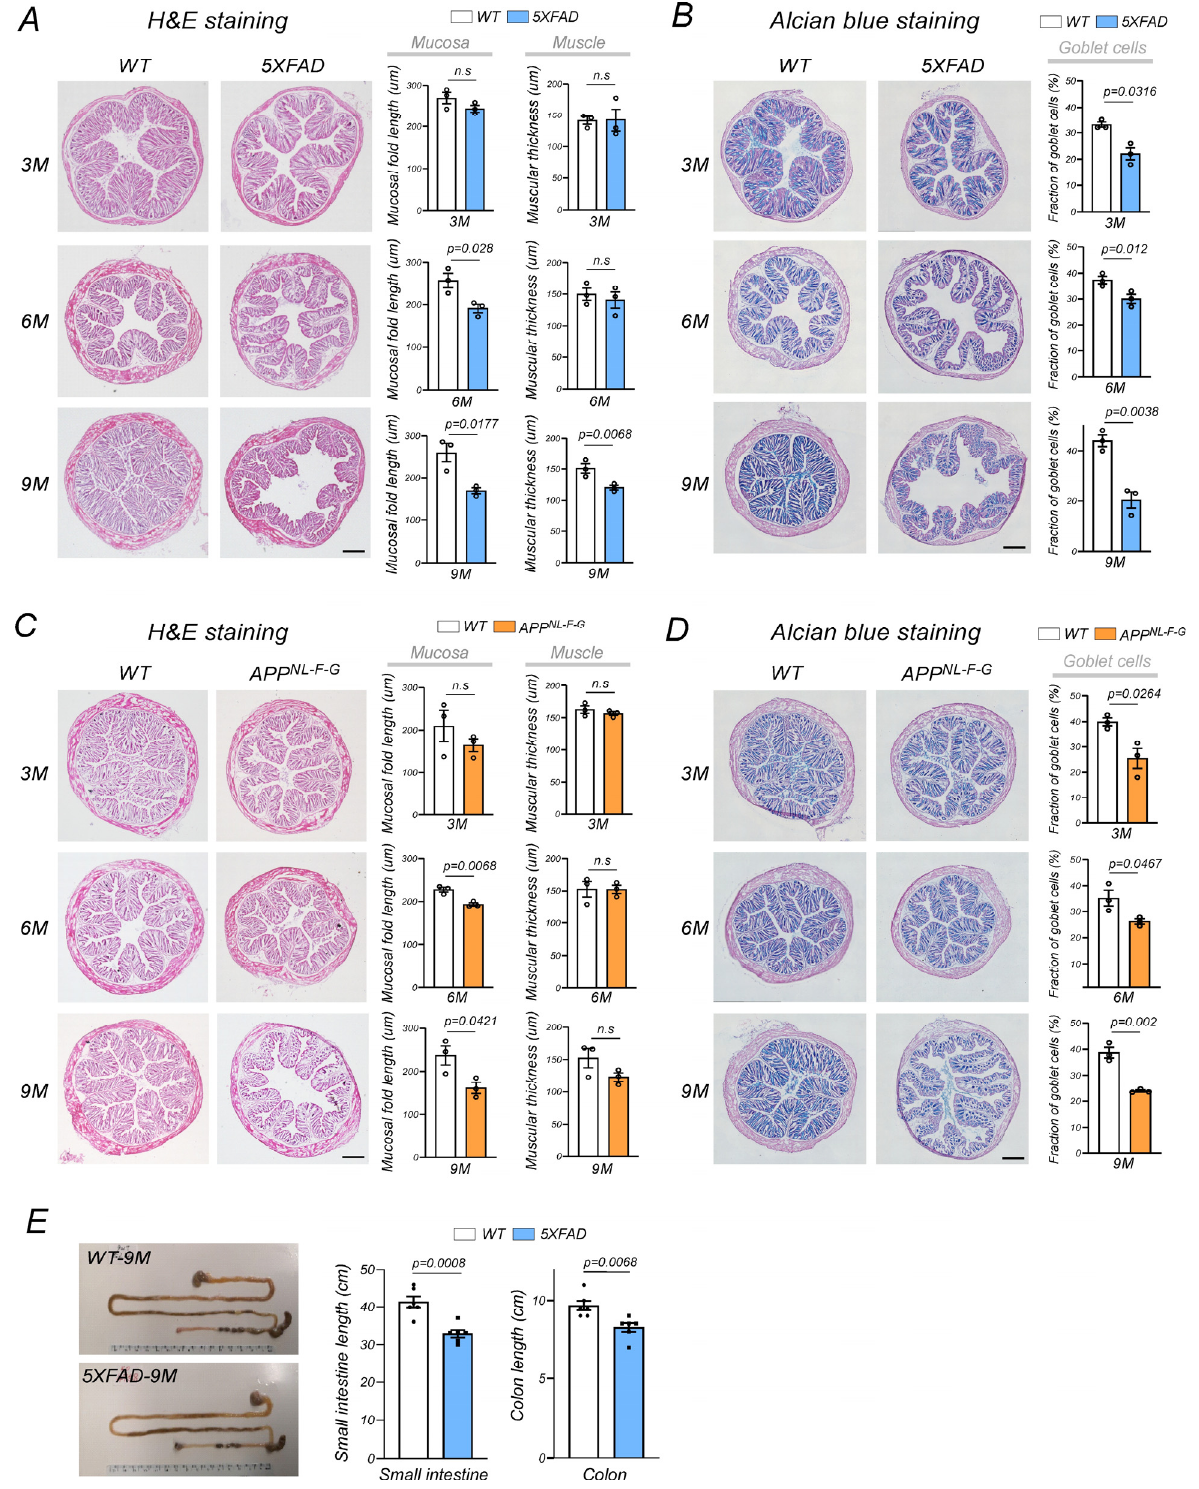
Figure 1. Colonic abnormalities in AD mouse models. ( A ) Hematoxylin and eosin (H&E) staining of colonic wild-type (WT) and 5XFAD mouse sections at 3- (3M), 6- (6M), and 9-months-old (9M). Cross-sectional mucosal fold lengths and muscular thickness were measured and quantified as shown ( n = 3 mice/group. Scale bar = 300 μ m). ( B ) Alcian blue staining of goblet cells in WT and 5XFAD mouse colons at different ages ( n = 3 mice/group. Scale bar = 300 μ m). ( C ) H&E staining of WT and APP NL-F-G colonic sections at different ages. Cross-sectional mucosal fold length and muscular thickness were measured and quantified as shown in histograms ( n = 3 mice/group. Scale bar = 300 μ m). ( D ) Alcian blue staining of goblet cells in WT and APP NL-F-G mouse colons at different